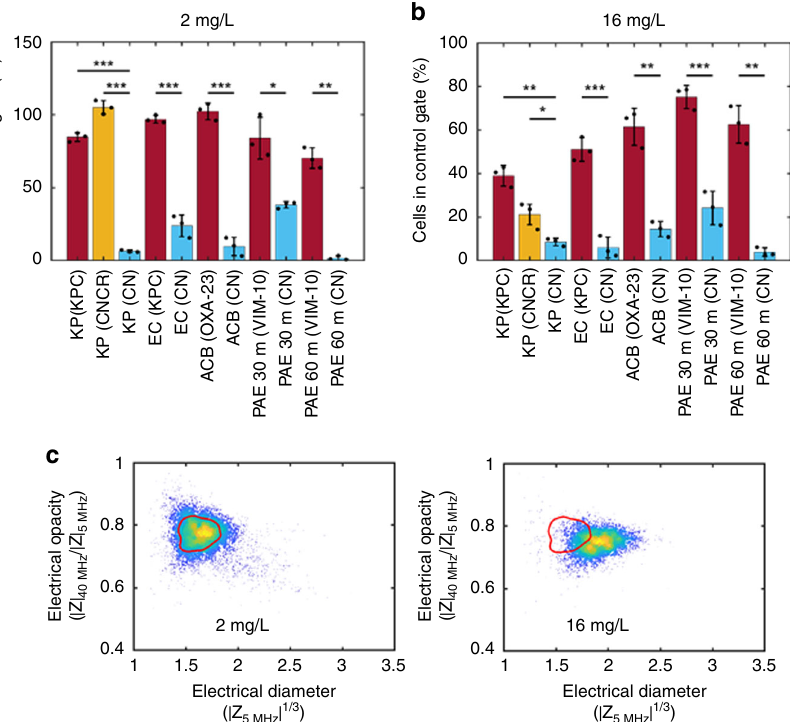
Fig. 4 Electrical breakpoint analysis for Meropenem. Eleven different strains of bacteria analysed by impedance cytometry after exposure to Meropenem at the clinical breakpoint. (KP K p neumoniae, EC E. coli, ACB A. baumannii, PAE P. aeruginosa ) (see Supplementary Fig. 2, protocol 2). a , b Each bar is the percentage of cells in the unexposed contour (or gate) after exposure to antibiotics at the clinical breakpoint. The susceptible / susceptible, increased exposure ( S/I ) and susceptible / resistant ( S/R ) boundaries are 2 and 16 mg/L, respectively. The bars show the mean ± SD for three biological replicates (* p < 0.05; ** p < 0.01; *** p < 0.001) with p values obtained using the Student ’ s t test for independent samples (one tailed). Red bars indicate resistant strains and blue bars indicate susceptible strains, as determined by broth micro-dilution. The orange bar (CNCR) is a carbapenemase negative strain that is carbapenem resistant. P values (from left to right) are as follows 1.04 × 10 − 4 , 2.66 × 10 − 4 , 7.14 × 10 − 4 , 2.46 × 10 − 5 , 1.43 × 10 − 2 , 1.15 × 10 − 3 , 1.97 × 10 − 3 , 3.00 × 10 − 2 , 2.19 × 10 − 4 , 2.40 × 10 − 3 , 6.13 × 10 − 4 , 2.63 × 10 − 3 . c Scatter plots for a CNCR strain of K. pneumoniae after exposure to Meropenem for 30 min at the S/NS breakpoint (2 mg/L) and the R/NR breakpoint (16 mg/L) concentrations. Source data are provided as a Source Data fi